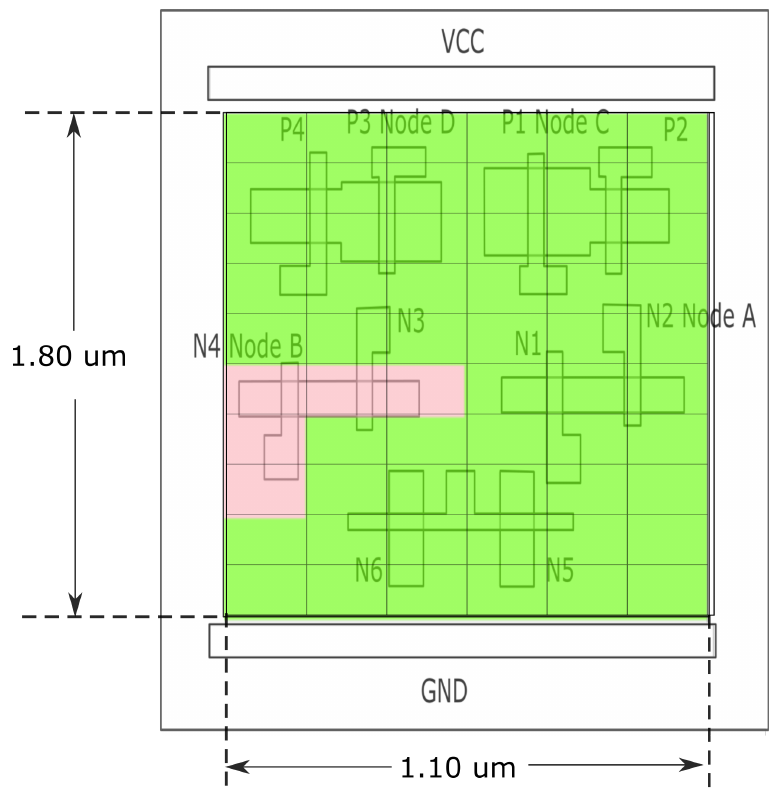
Figure 9. Sensitive map for Quatro design of SRAM with all ‘0’ stored data pattern and 90 pJ laser